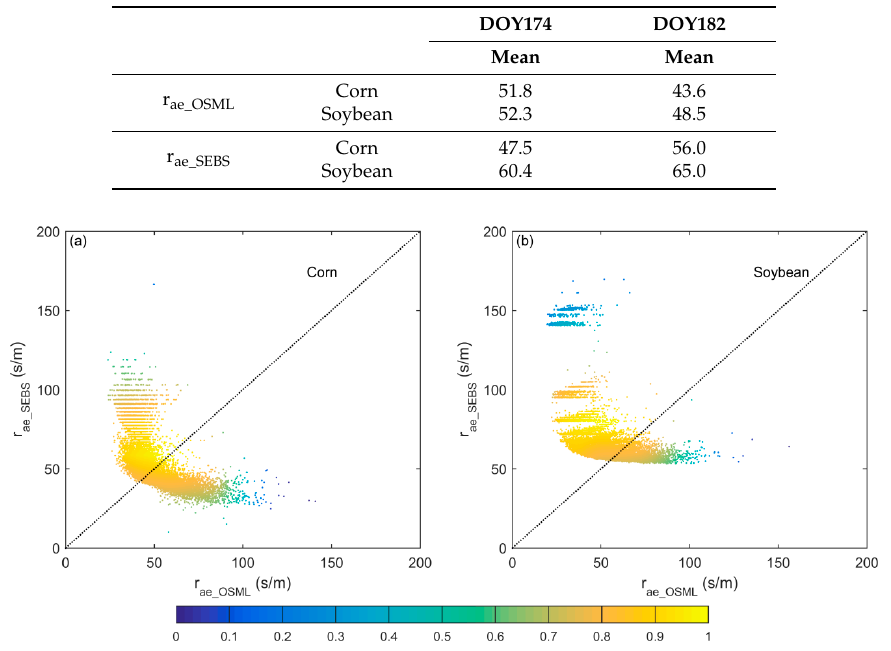
Figure 9. Intercomparison between r ae_OSML , r ae_SEBS for: ( a ) cornfields; and ( b ) soybean fields on DOY 182 of 2002 (color shading indicates pixel density) .